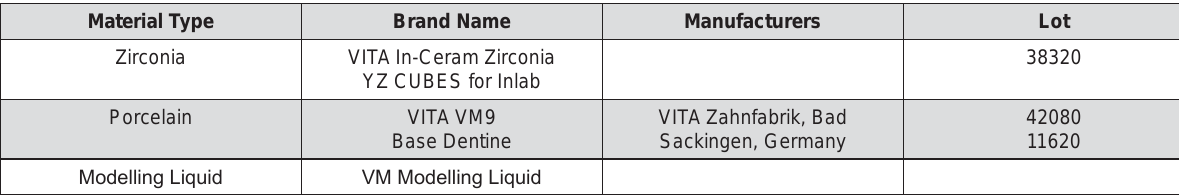
Figure 1- Material type, brand name, and manufacturers used in the